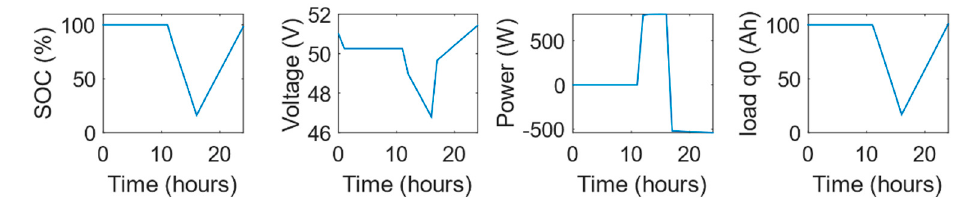
Figure 13. BESS parameters.